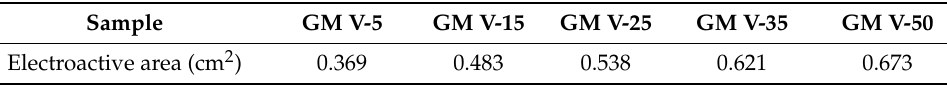
Table 2. The electroactive areas of the graphene mesh (GM)